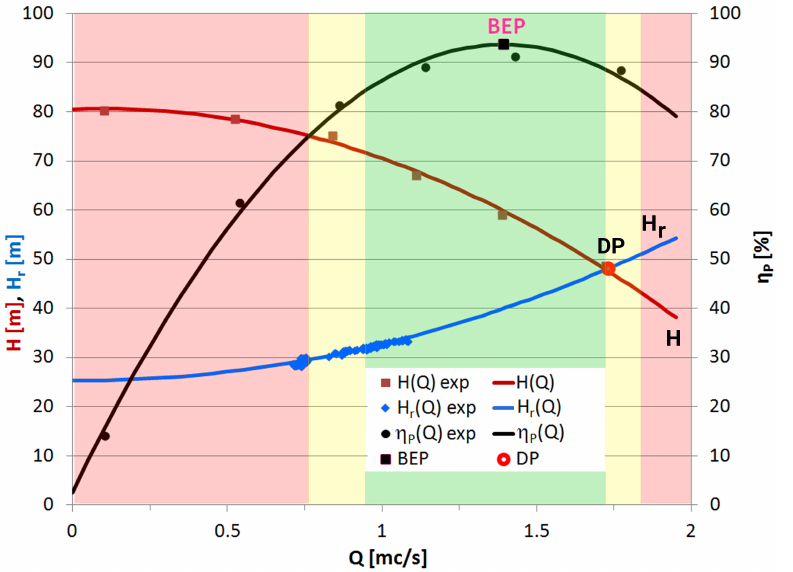
Figure 18. The duty point (DP) of a Worthington 500LNN-775A double suction pump of 1 MW at speed of 993 rpm operating in Timi¸soara drinking water